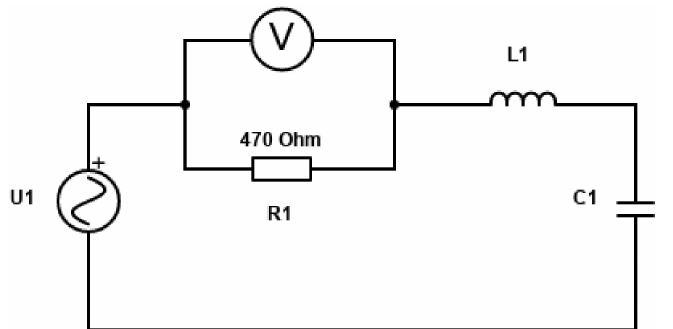
Figure 11. Serial RLC circuit: U 1 , signal source; R 1 , resistor; V, registration unit; L 1 , inductor; C 1 , capacitor.